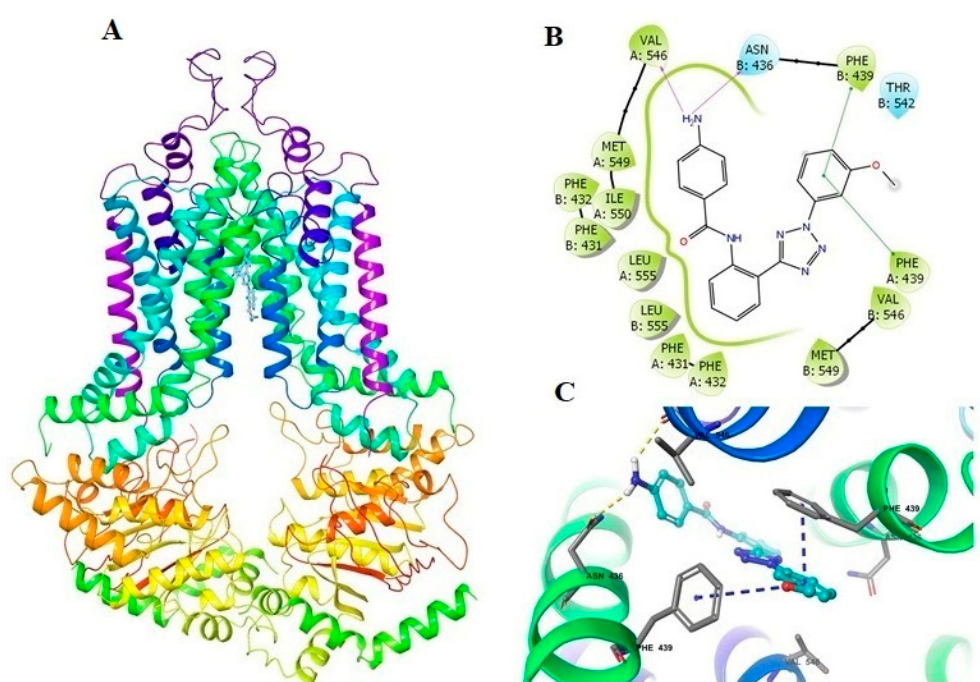
Figure 5. The molecular modeling of VKNG-1 and human ABCG2. The binding site of VKNG-1 within human ABCG2 ( A , B ). The two-dimensional diagram of VKNG-1 and human ABCG2 was shown. The residues within 3 Å are represented as colored bubbles: cyan—polar, green—hydrophobic. The purple arrows show hydrogen bonds and green short lines indicate π - π interactions ( C ). Docked position of VKNG-1 within the binding site of ABCG2. VKNG-1 is shown as ball and stick mode with the atoms colored: carbon—cyan, nitrogen—blue, oxygen—red, hydrogen—white. Important residues are in the form of sticks with grey color. Hydrogen bonds and π - π stacking interactions are indicated with yellow and cyan dotted short line, respectively.